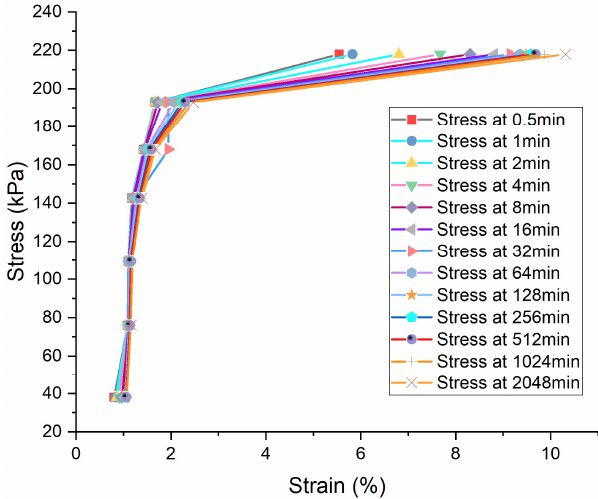
Figure 18. Isochronous (𝜎 (cid:2869) − 𝜎 (cid:2871) ) - (𝜀 (cid:2869) ) curves of Specimen No. 12, 4 FTHs.